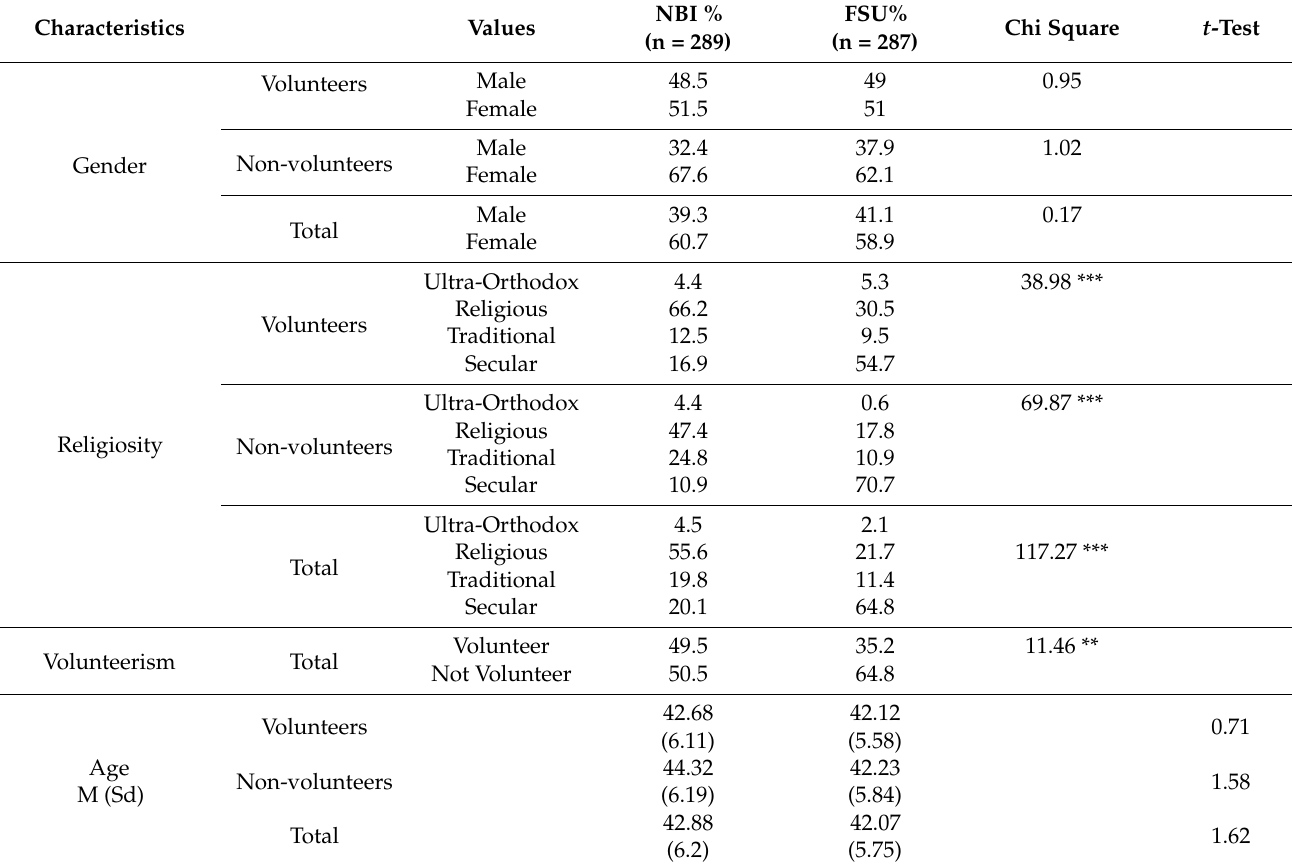
Table 1. Sample characteristics (n =